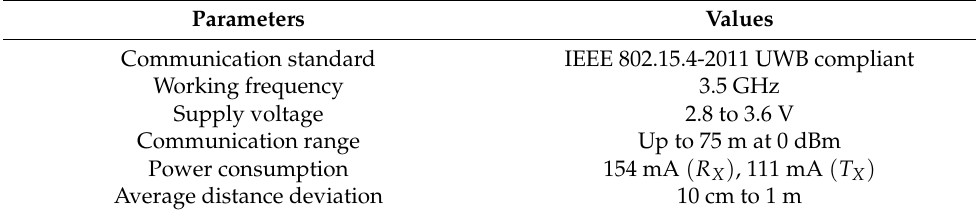
Table 1. Technical specifications of Decawave ranging